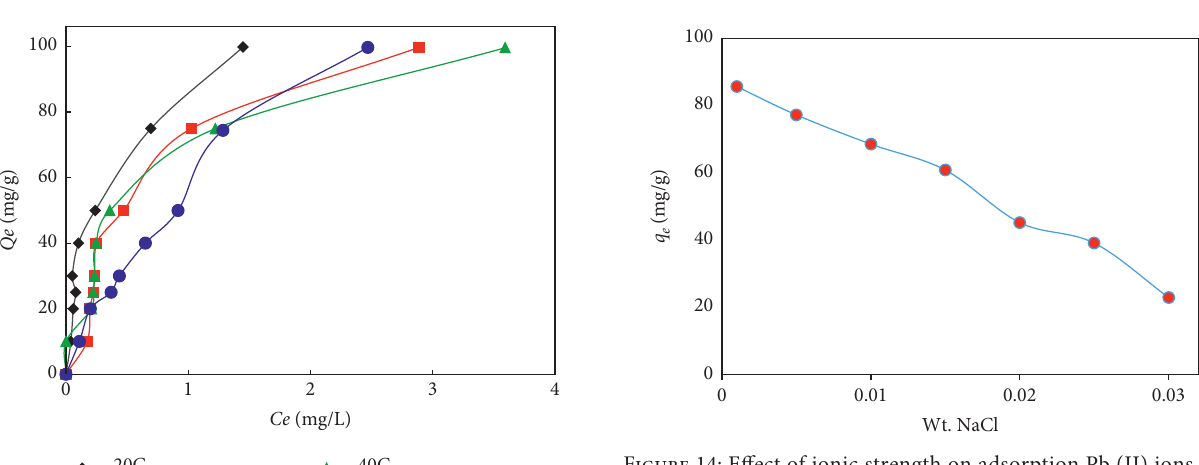
Figure 14: Effect of ionic strength on adsorption Pb (II) ions on